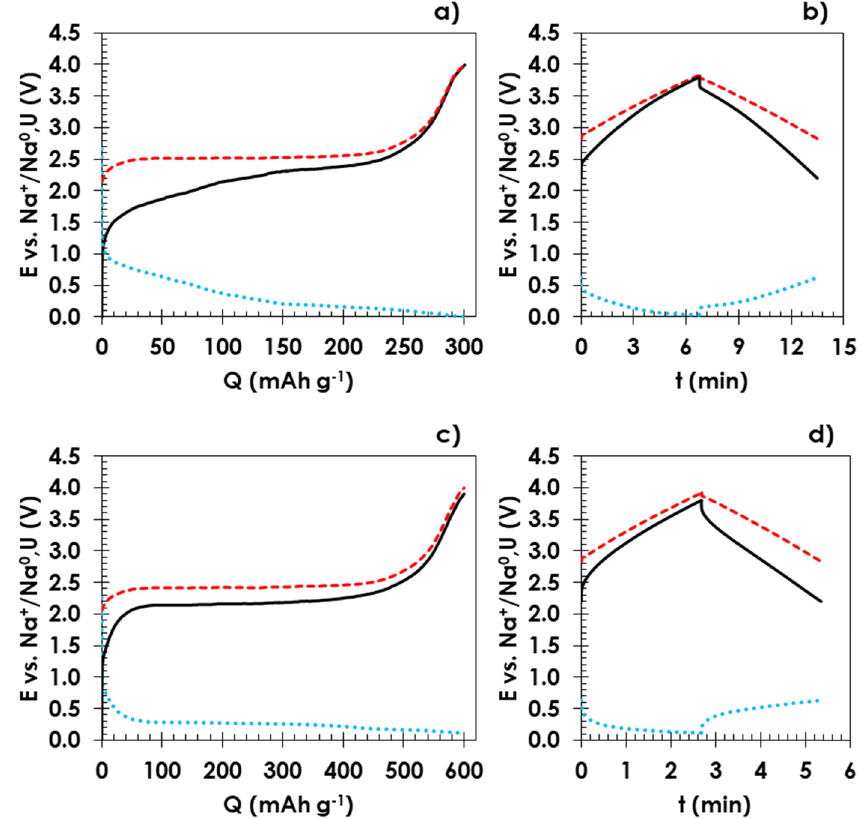
Figure 4: Pre - sodiation of a negative electrode ( a ) hard carbon, and ( c ) tin phosphide in an NIC with NaBH 4 /AC - positive electrode. Galvanostatic pro fi les of the composite - positive electrode ( red dashed line ) , - negative electrode ( blue dotted line ) , and voltage of the cell ( black solid line ) . Galvanostatic charge/discharge pro fi les of NIC with ( b ) HC - negative electrode at 125mAg − 1 and with ( d ) SnP - negative electrode at 250mAg − 1 ( values given per gram of the total mass of the electrodes ) in the voltage range 2.2 –